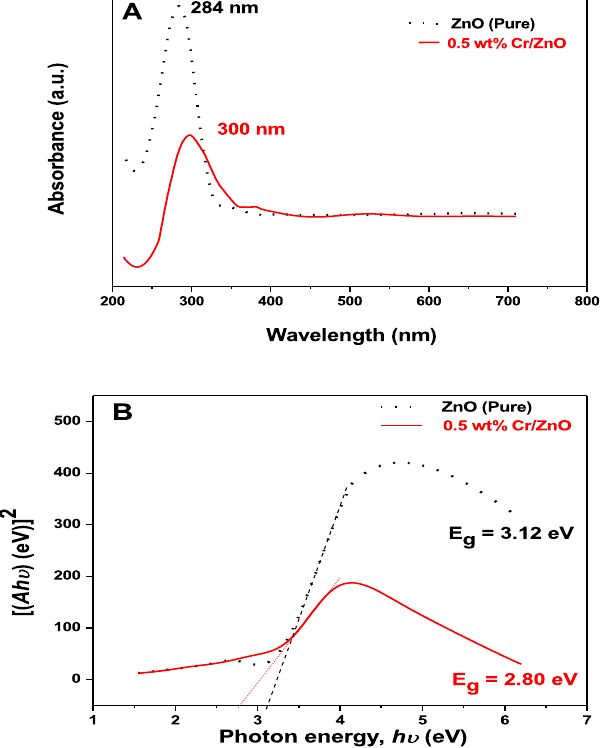
Figure 6. ( A ) Absorbance spectra and ( B ) Band gap energy plots for the ZnO (pure) and 0.5 wt% Cr/ZnO NS